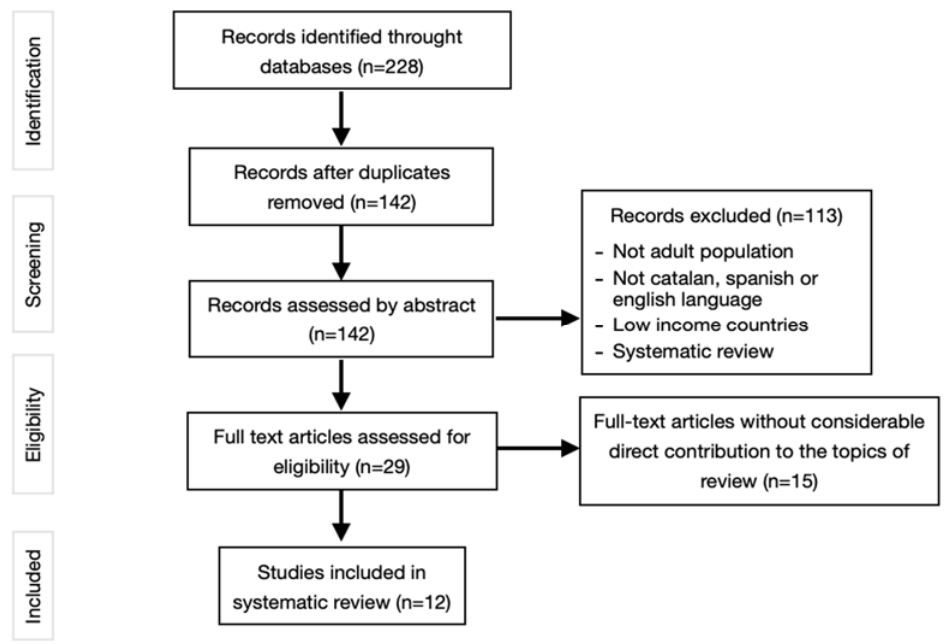
Figure 1. Flow chart showing the electronic research, identification, and selection process for the reviewed articles.